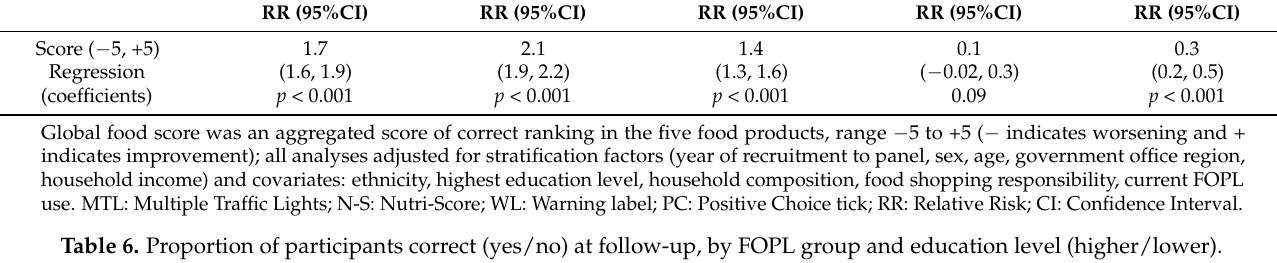
Table 6. Proportion of participants correct (yes/no) at follow-up, by FOPL group and education level